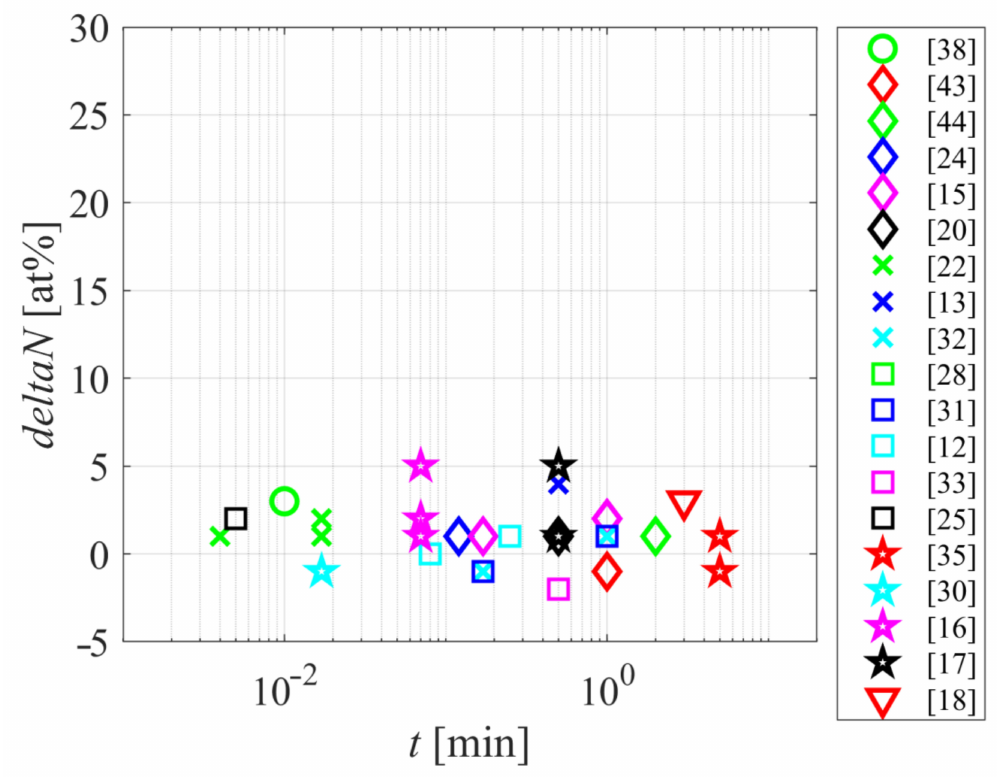
Figure 5. The di ff erence in nitrogen concentration as probed by XPS versus the plasma treatment time.